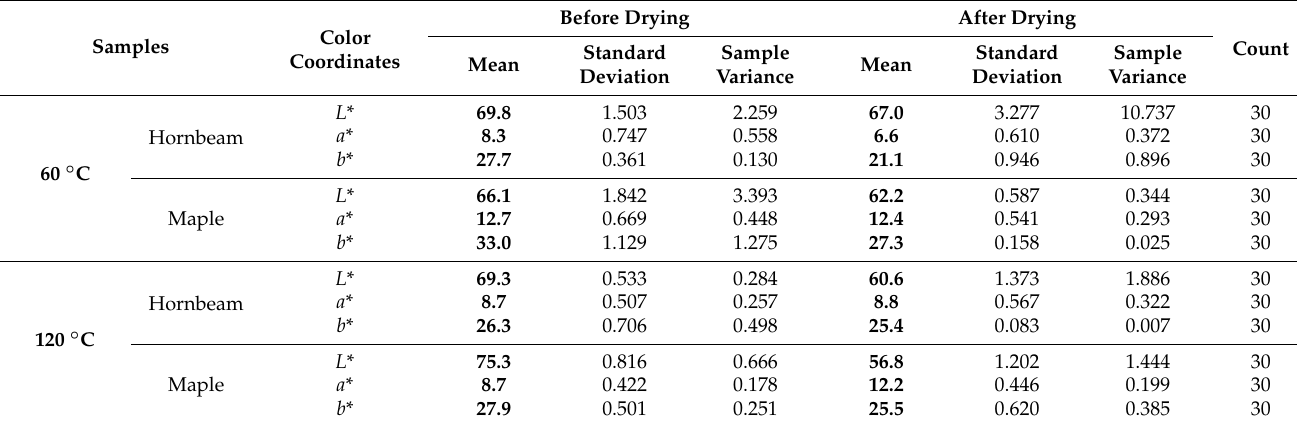
Table 4. Average values and basic statistical characteristics of the coordinates of the color space L *, a * and b * for samples from hornbeam and maple.